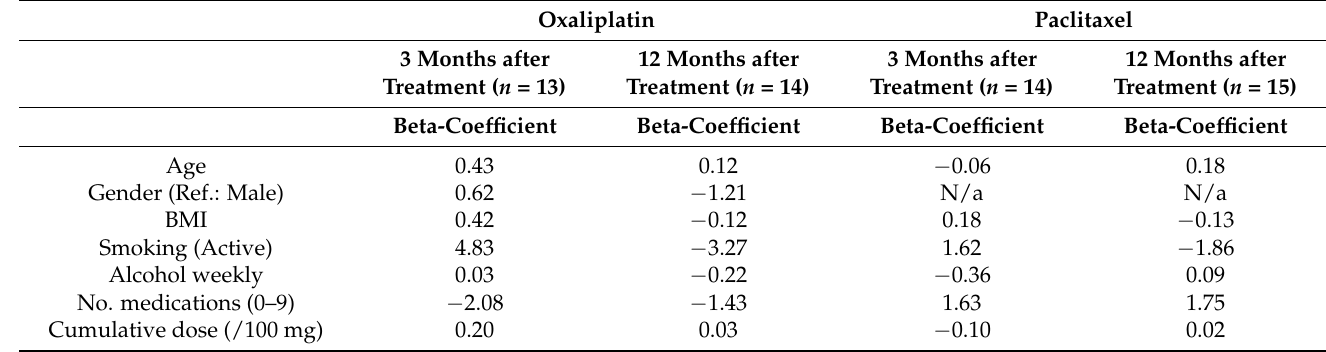
Table 2. Linear correlations between patient- and treatment-related factors, baseline VPT scores, and CIPN18 scores at 3 and 12 months for patients treated with oxaliplatin or paclitaxel. Adjusted for age, gender, BMI, and cumulative